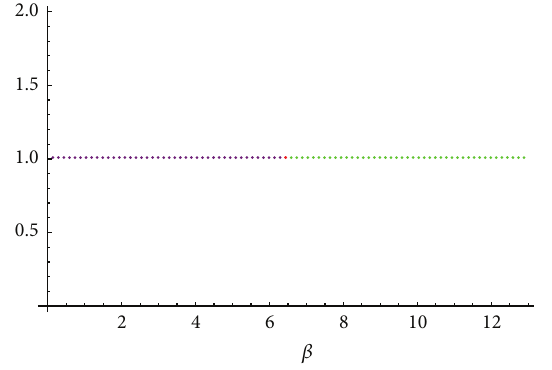
Figure 3: Bifurcation portrait of H2 point ( 𝑠 = −1 ): (𝜎,𝑐, 𝑏 2 ) = (30, 4.1861,−1) . Region 0 (green), Region 1 (purple) (red dot marks 𝑏 𝑐𝑟 ).